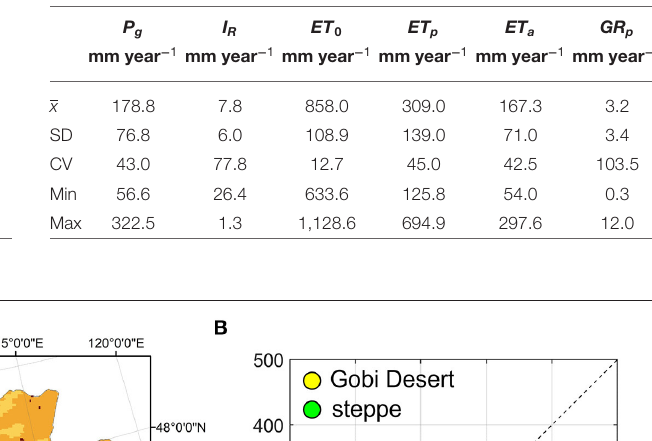
TABLE 3 | Statistics of the water balance components simulated in HYDRUS-1D over the 41 weather stations.